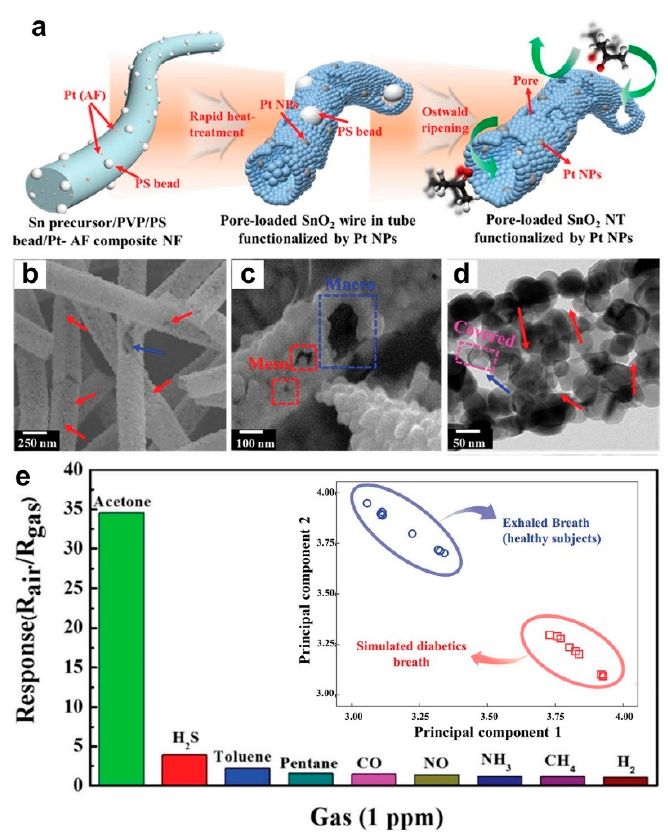
Figure 8. ( a ) Schematic illustration of the Sn precursor/PVP/PS bead/Pt@AF composite NF (left), pore loaded SnO 2 wire in tube functionalized by Pt NPs (middle), and pore loaded SnO 2 NTs functionalized by Pt NPs (right). ( b , c ) Porous SnO 2 NTs (PS_SnO 2 NTs) and ( d ) TEM image of PS_SnO 2 NTs. ( e ) Selective characteristics of Pt-PS_SnO 2 NTs at 350 ◦ C. Inset: Pattern recognition based on PCA using sensor arrays (PS_SnO 2 NTs, Pt-PS_SnO 2 NTs, and Pt-SnO 2 NTs) [6].